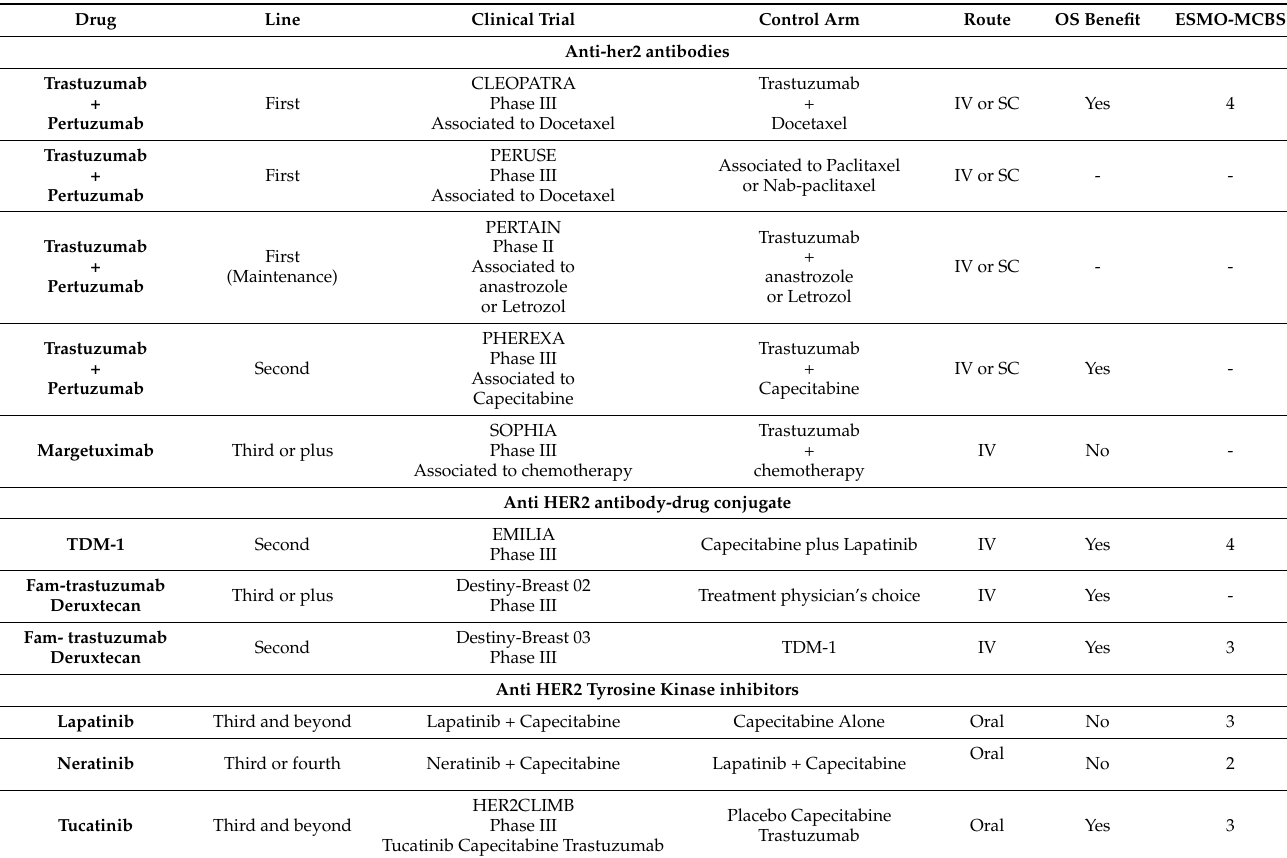
Table 1. Approved Anti-HER2 Therapies in Advanced Breast